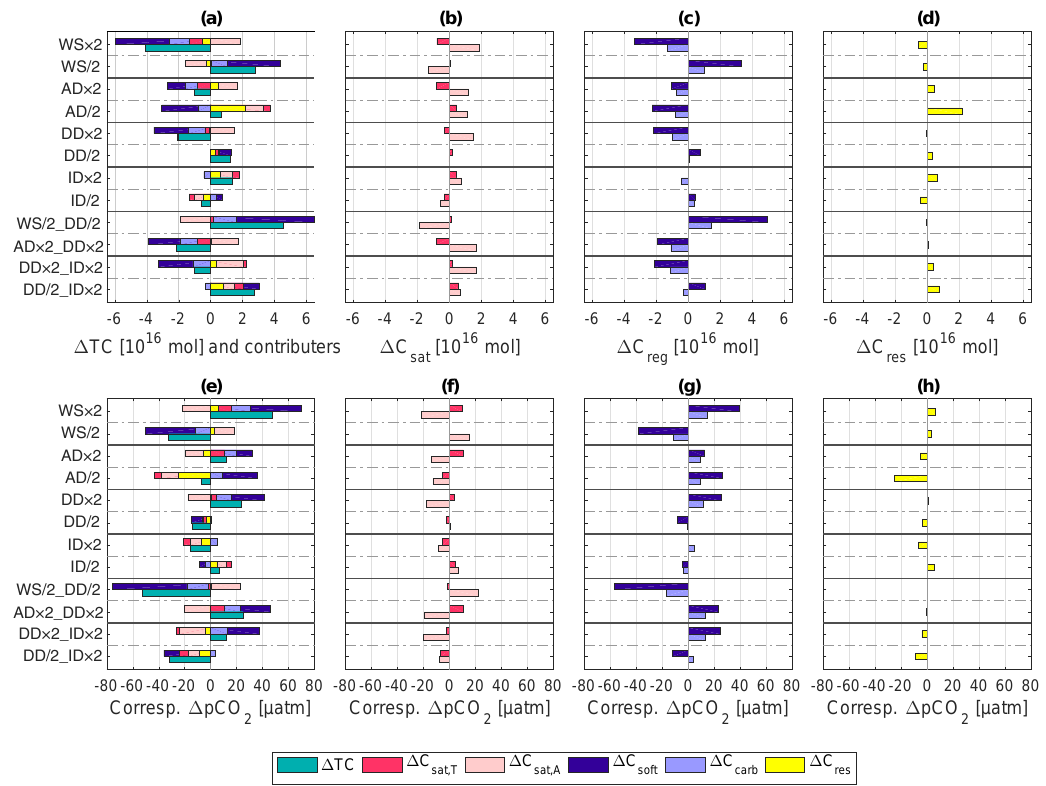
Figure 2. In panel (a) , green bars show observed (cid:49) TC inventory for SE1–SE12 compared to the TC inventory of the control PIES278. Other bars show relative contributions to (cid:49) TC inventory by changes in the solubility (due to temperature in red, due to preformed alkalinity in pink; panels a, b ), biological soft-tissue (dark blue, panels a, c ) and hard-tissue (light purple, panels a, c ) pumps. The residual of the theoretical contributions by changes in C soft , C carb and C sat to (cid:49) TC (calculations made using Eqs. B2–B1) and the observed model (cid:49) TC is denoted C res (yellow bars). The horizontal axis shows the magnitude of changes given in 10 16 mol ( ∼ 120PgC). The lower panels (e–h) show approximate p CO atm equivalent given in µatm. Hence, this shows how big the difference in p CO atm would be between ensemble 2 2 members if we were not restoring to 278µatm. Note that a positive (negative) (cid:49) TC indicates a higher (lower) storage of CO 2 in the ocean, which would cause a lower (higher) p CO atm 2